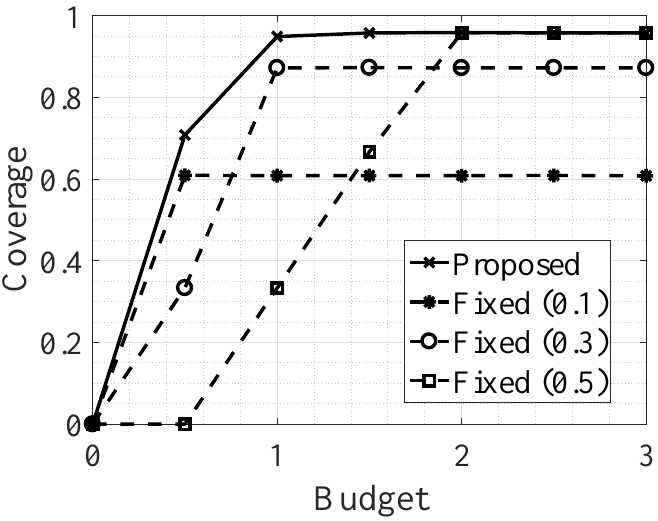
Figure 4. Coverage vs. monetary